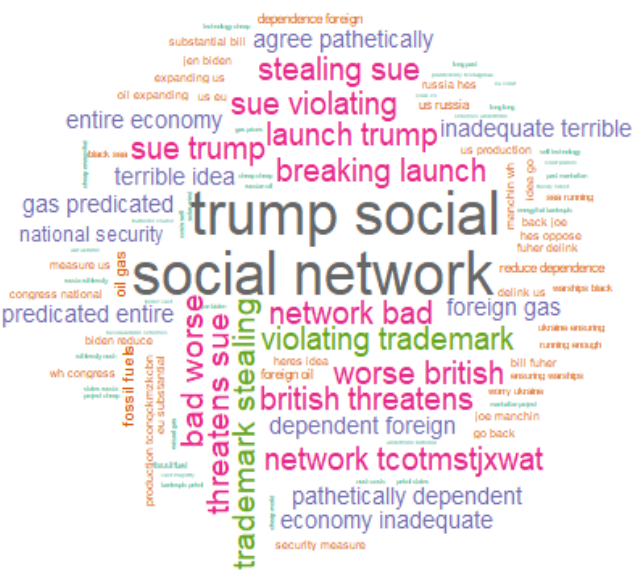
Figure 7. Wordcloud by bigrams period 2.